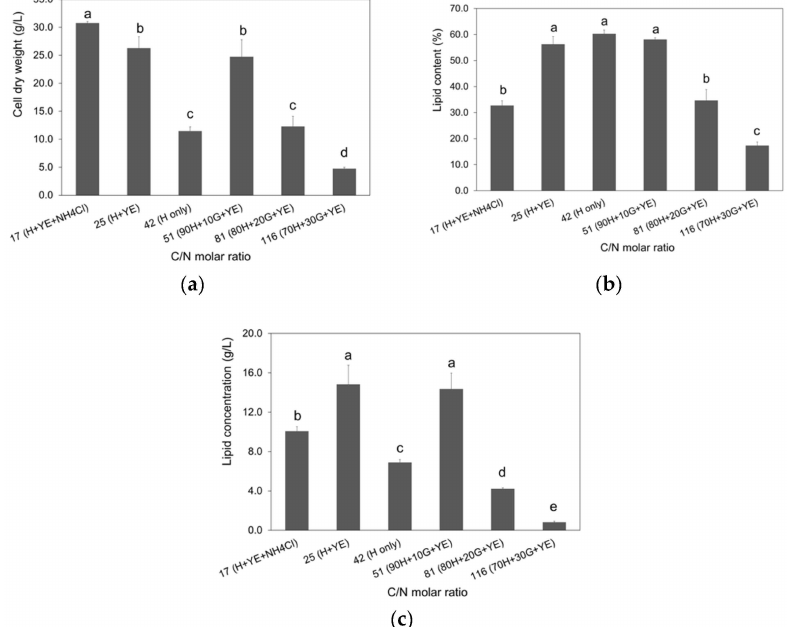
Figure 2. Cell dry weight ( a ), lipid content ( b ) and lipid concentration ( c ) when culturing R. glutinis TISTR 5159 in hydrolysate with different C/N molar ratios adjusted by addition of nitrogen sources (YE/NH 4 Cl) or glycerol (G), where C/N of 42 represents the hydrolysate (H). Numbers in front of the letters indicate the mixing volume ratio of hydrolysate and glycerol in the media. Different letters above the bars indicated significant differences in mean values at 95% confidence